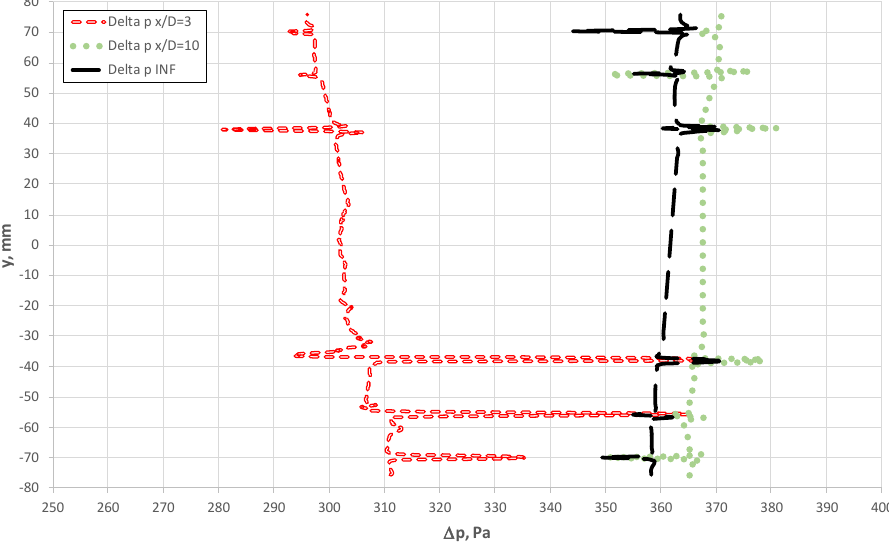
ff erential pressure along axes of the flow-averaging chambers ( ∆ p = p + − p − Figure 18. Differential pressure along axes of the flow-averaging chambers (Δp = p + − p − ). Figure 18. Di